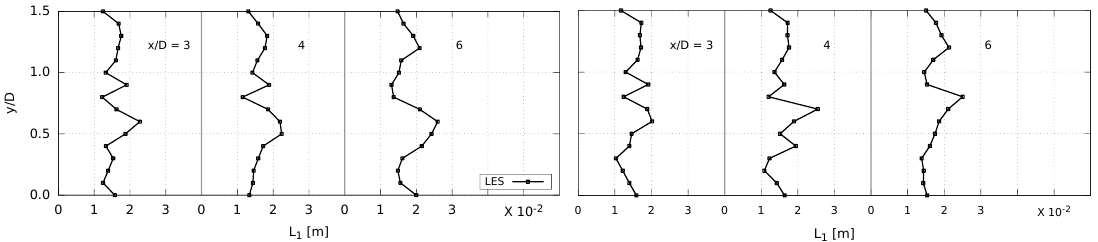
Figure 13. Vertical profiles of L 1 behind the AD with inflow Ti3, disks: C T = 0.42 ( left ) and C T = 0.62 ( right